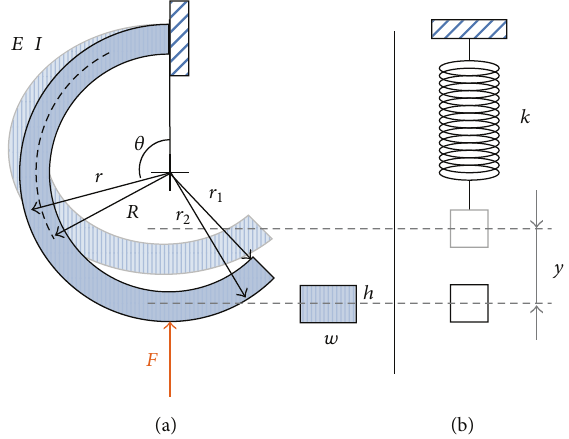
Figure 2: The solid mechanic model (a) and the simplified model (b) of the curved